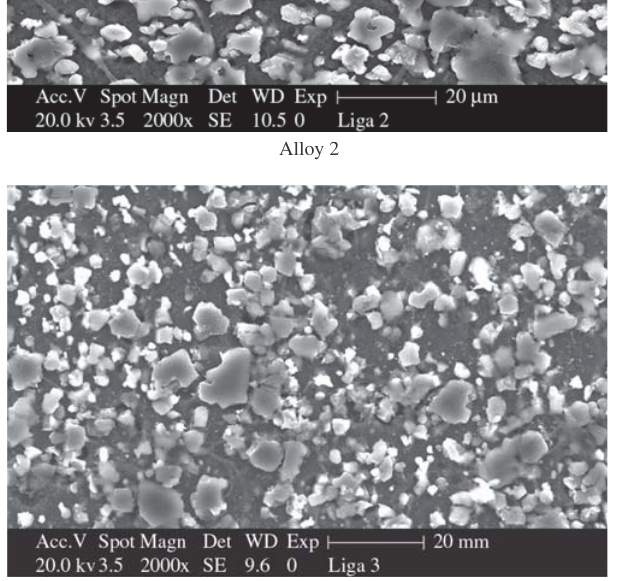
Figure 4. Laue photographs of specimens taken from alloy 1, perpendicular to the rolling direction: a) Hot rolled at 450 °C – 72% total reduction in t hickness; b) Cold rolled – 70% total reduction in thickness. The diffraction lines have a continuous and uniform intensity appearance, which indicate